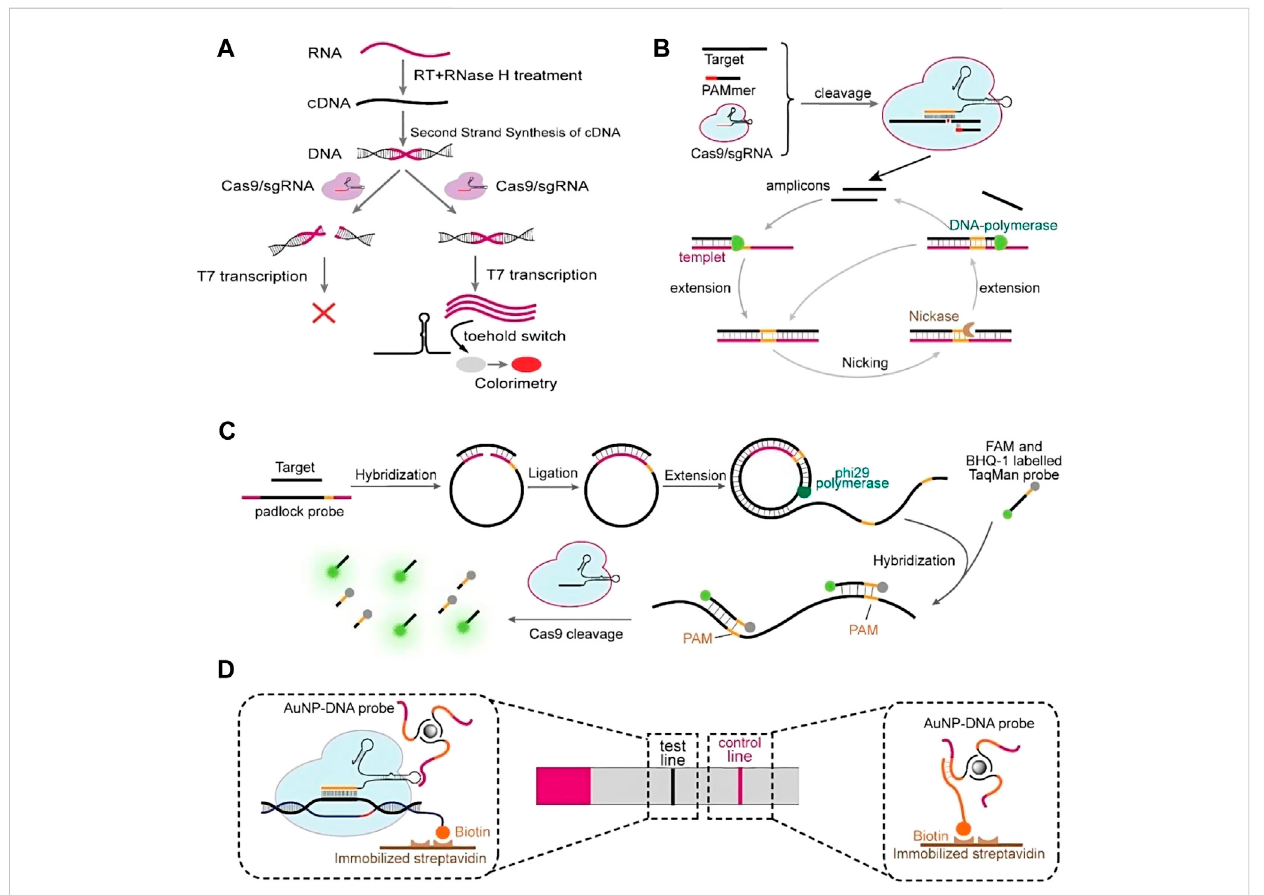
CRISPR-Cas9-mediatedbiosensingassays. (A) Cas9-basedNASBACC assaythatcandistinguishsingle-basemismatcheslocatedinthePAMregion. (B) CAS-EXPAR for ultrasensitive detection of single-stranded targets. (C) RACE for miRNA detection. (D) CASLFA is a Cas9-based lateral fl ow assay that enables fast and fi eld-deployed detection. Reprinted with permission from Wang et al. (2020a). Copyright © 2020 Elsevier B.V. All rights